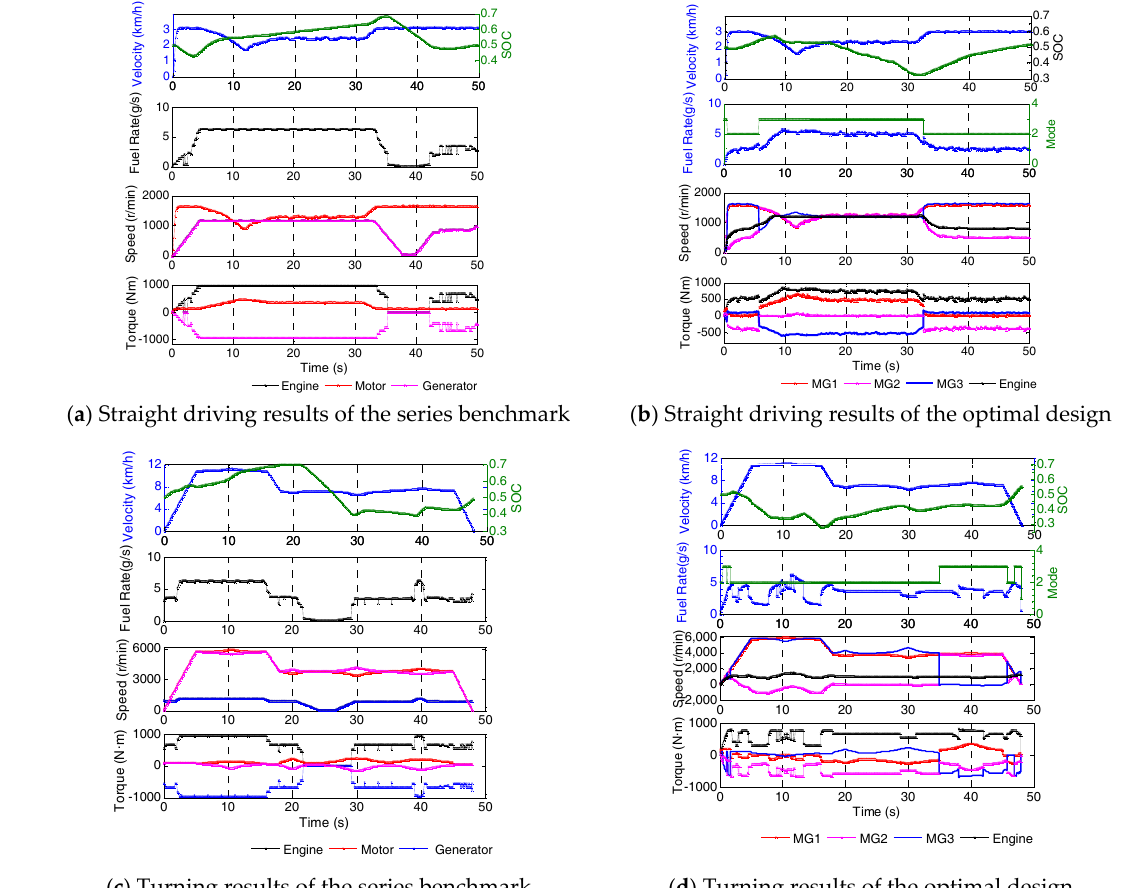
Figure 17. Control results comparison under typical cycles.